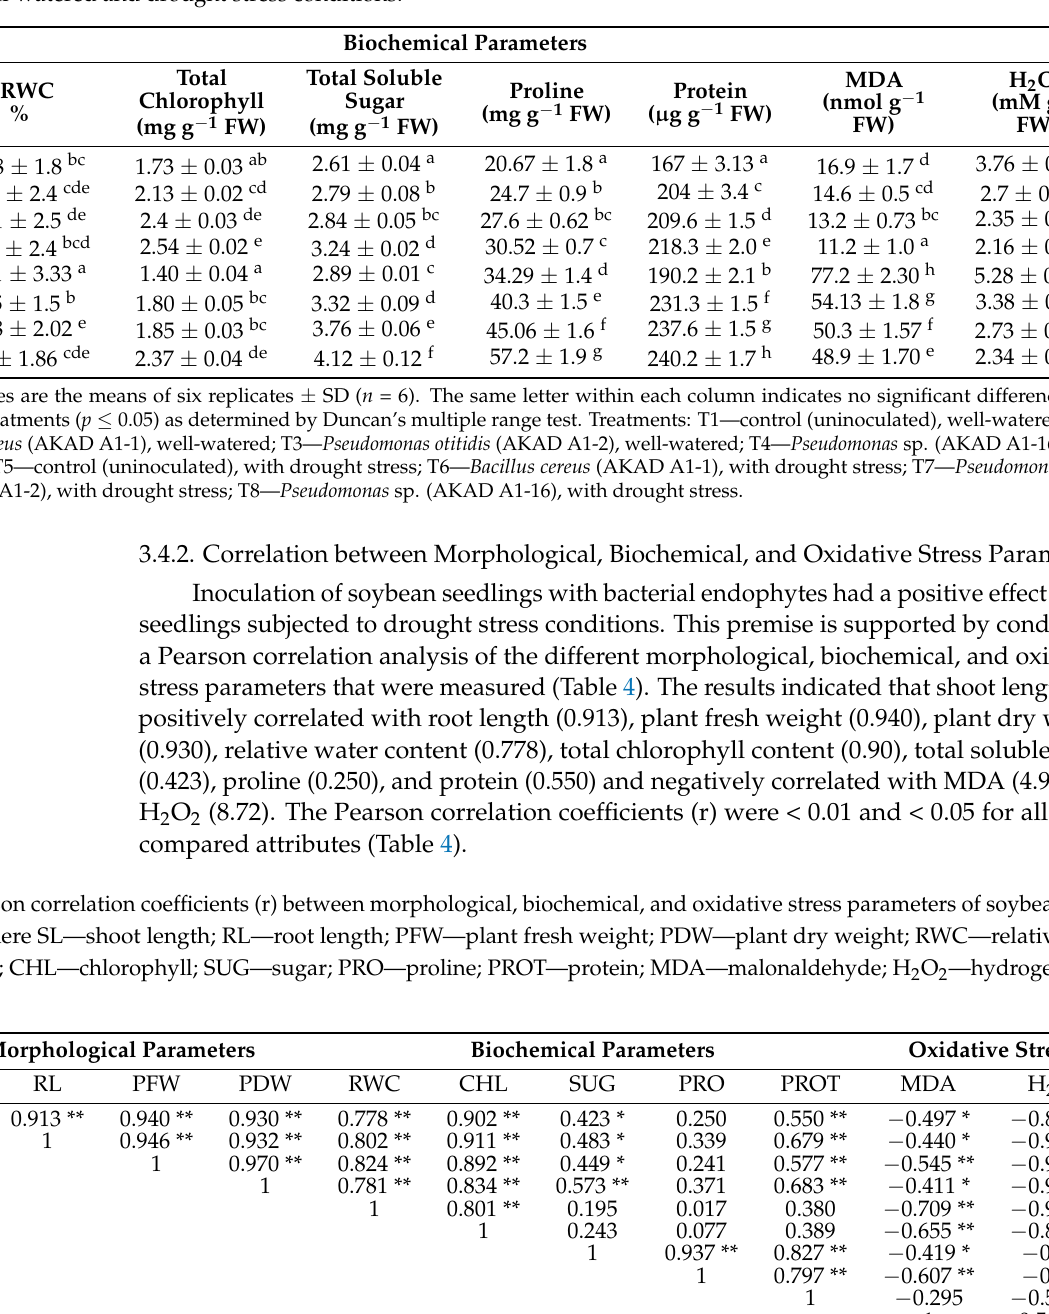
Table 3. Effect of inoculation of soybean seedlings with drought-tolerant bacterial endophytes on biochemical parameters under the well-watered and drought stress conditions.